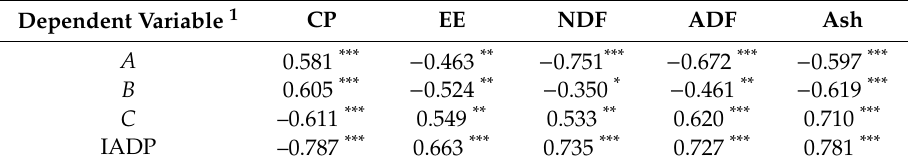
Table 5. Pearson’s correlations between chemical composition, ruminal degradability parameters of crude protein, and intestinally absorbable digestible protein of common vetch grains.